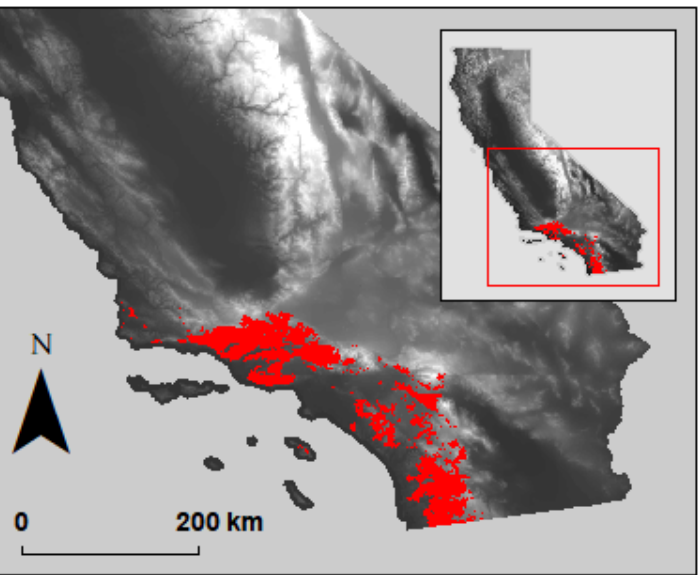
Figure 1. Study area, marked in red. The study area encompassed the 1818 fire scars examined in this study, which occurred from the year 1952 through 2017. Only fire scars in which ≥ 50% of the burned area consisted of either Southern California coastal scrub or dry mesic chaparral according to the FVEG land cover dataset produced by CALFIRE-FRAP, as well as ≥ 50% cover by mixed chaparral, chamise-redshanks chaparral, or coastal scrub according to EVT vegetation maps, were included.